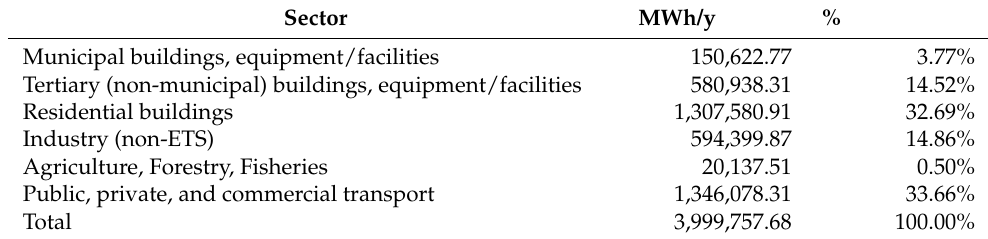
Table 6. Energy consumption distribution (MWh/year).